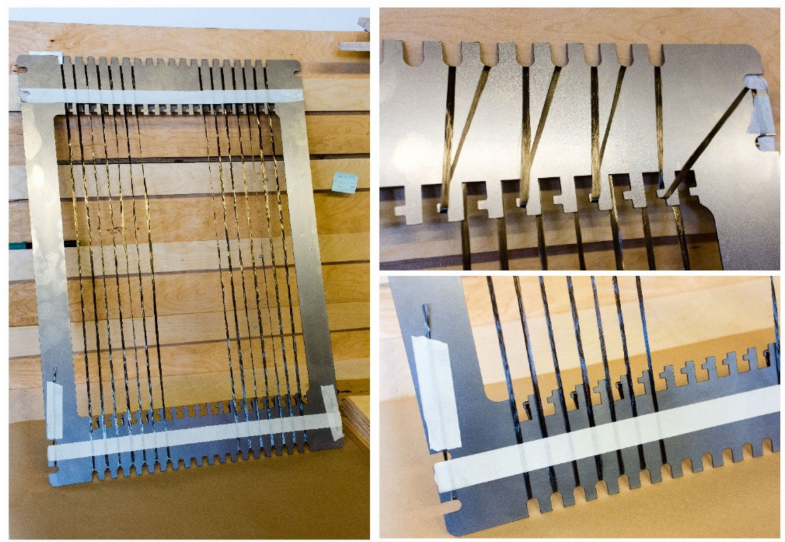
Figure 2. Frame for untensioned fibers alignment. Aligned fibers ready for positioning between the veneer layers ( left ); close-up of the winding layout on the backplane ( upper right ) and of aligned fibers on the front plane ( down right